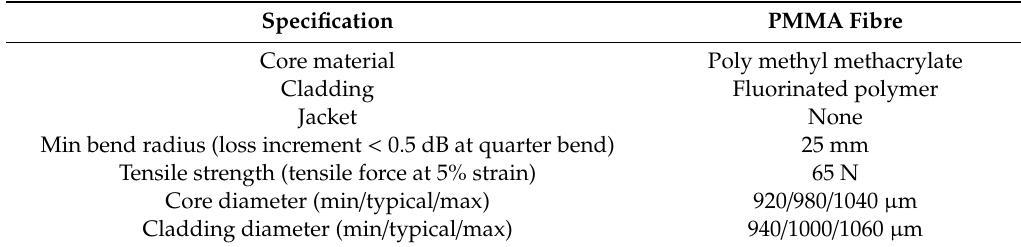
Table 1. Poly methyl methacrylate (PMMA) fibre specification.